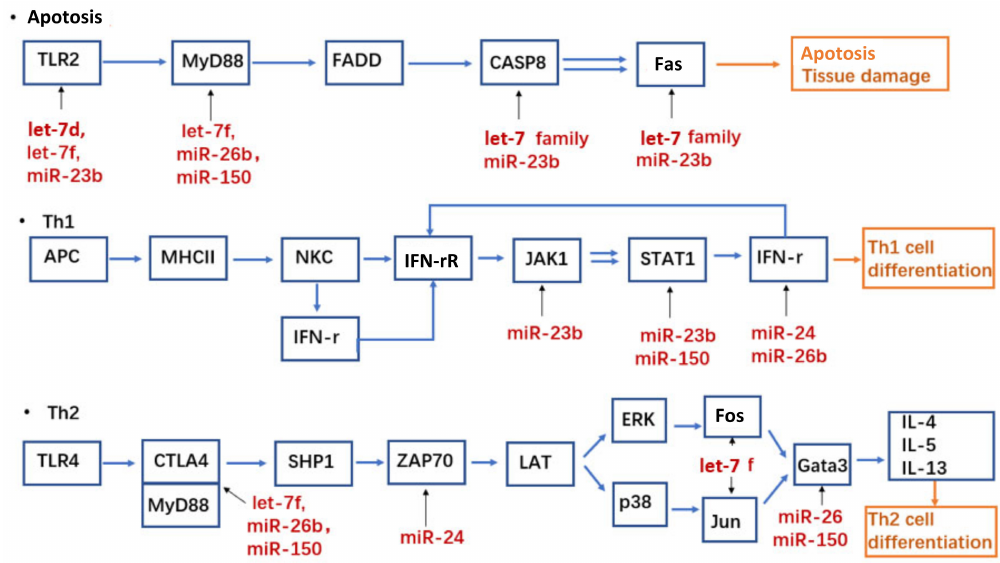
Figure 5. TargetScanHuman database. The prediction of the relations between target miRNAs and mRNAs in the pathways of apoptosis activity, Th1 cell differentiation, and Th2 cell